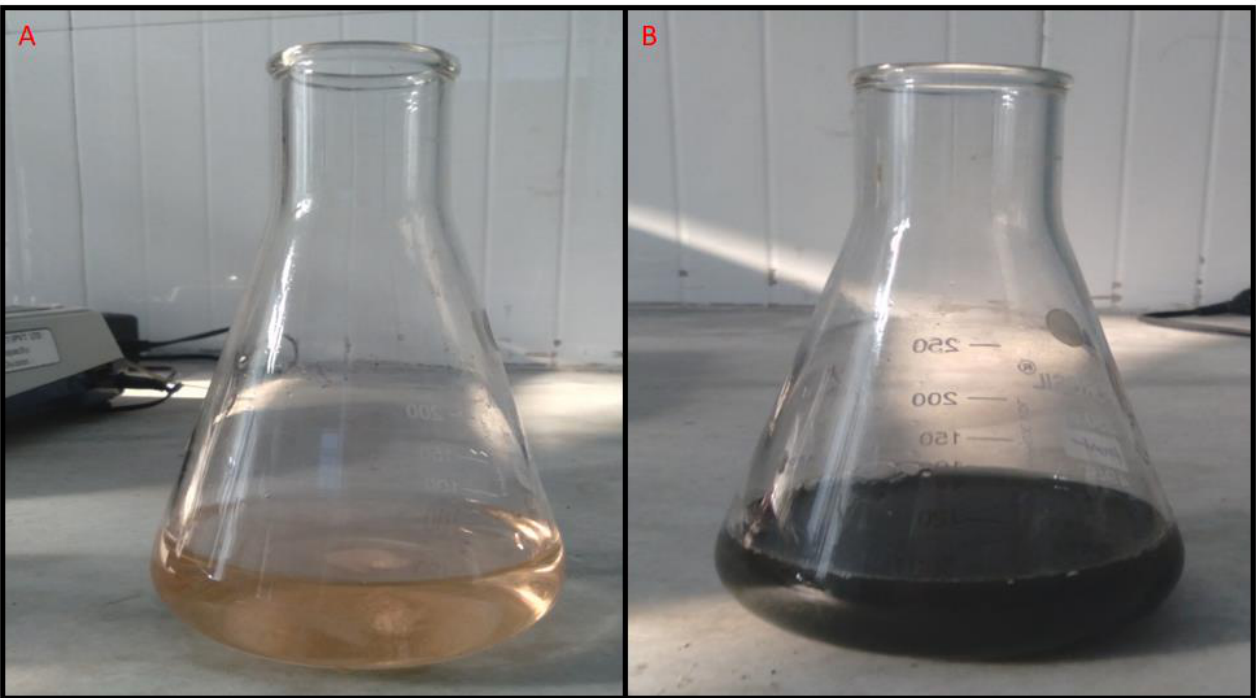
Figure 1. Representation of ( A ). silver nitrate mixed with plant extract soon after mixing; ( B ). silver nitrate with plant extract after 24 h.